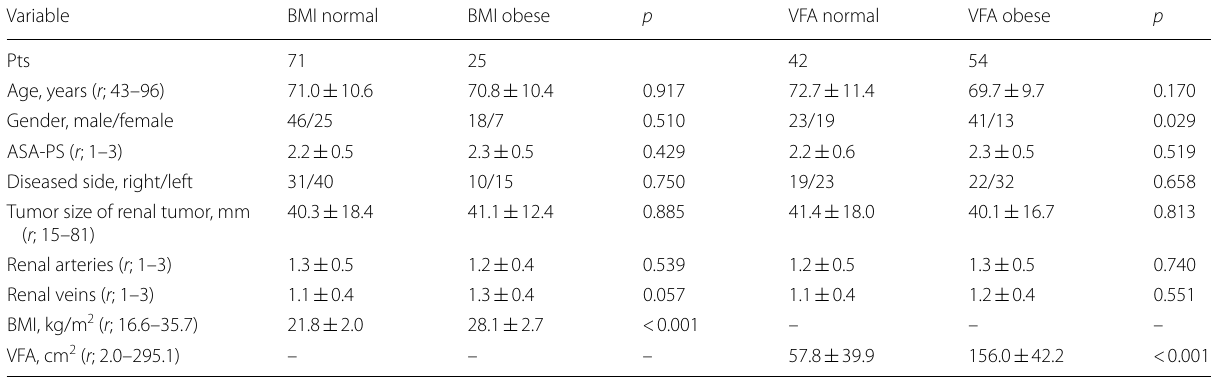
Data are presented as mean